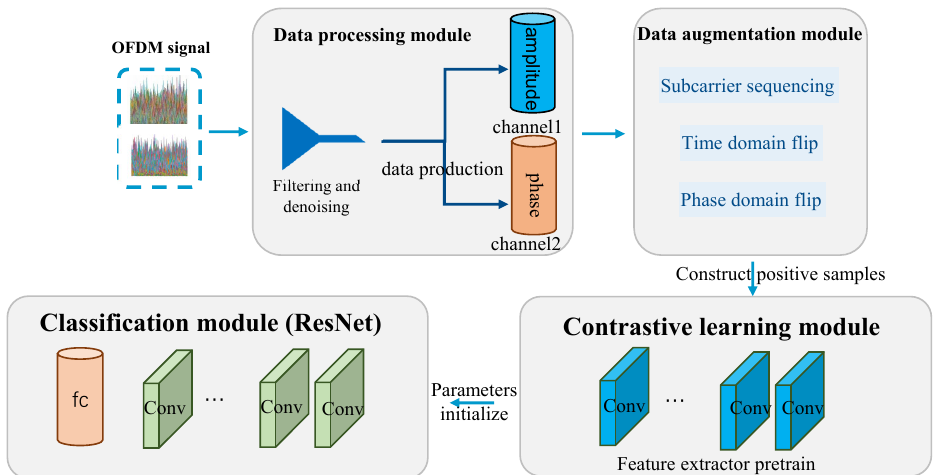
Figure 2. Overall structure of OFDM signal classification. There are four parts in our structure, the data processing module will generate two-channel datasets, and the data augmentation module will generate positive samples for constrastive learning. Then, we will pretrain the contrastive learning module and initialize the classification module with pretrained model’s